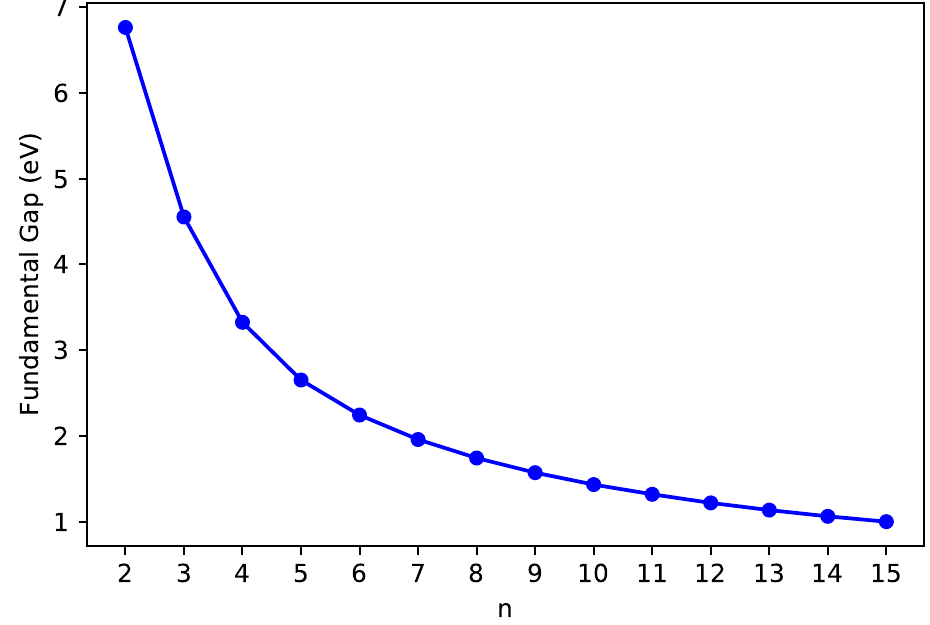
Figure 5. Fundamental gap of ground-state n -pyrene, calculated by spin-unrestricted